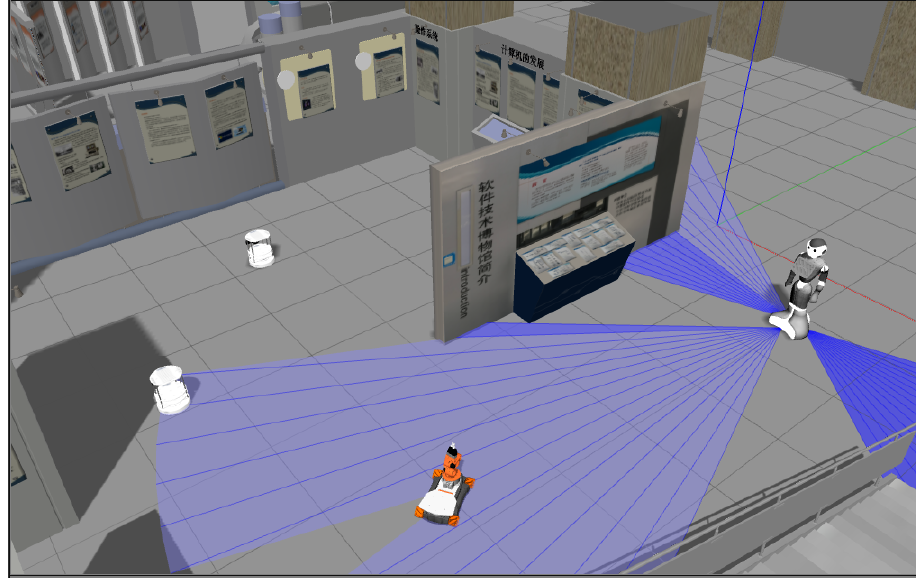
Figure 8. Group of robots navigating in the same